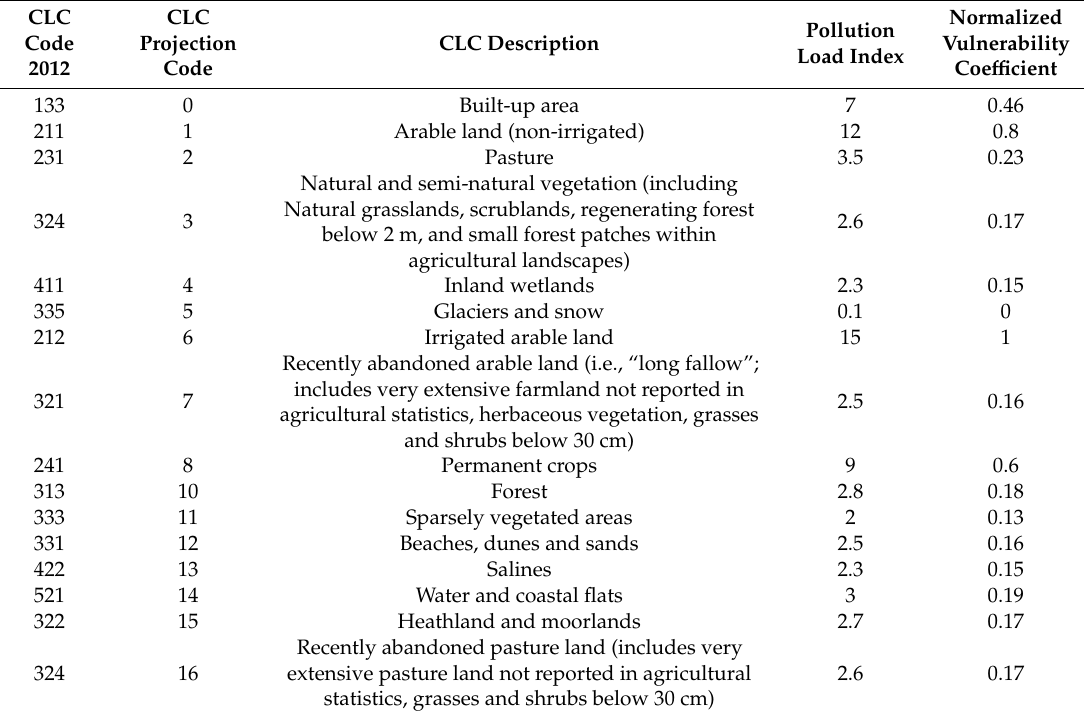
Table 4. Corine land cover classes and relative pollution load index applied for the future scenarios (2040s) in the Grand Est